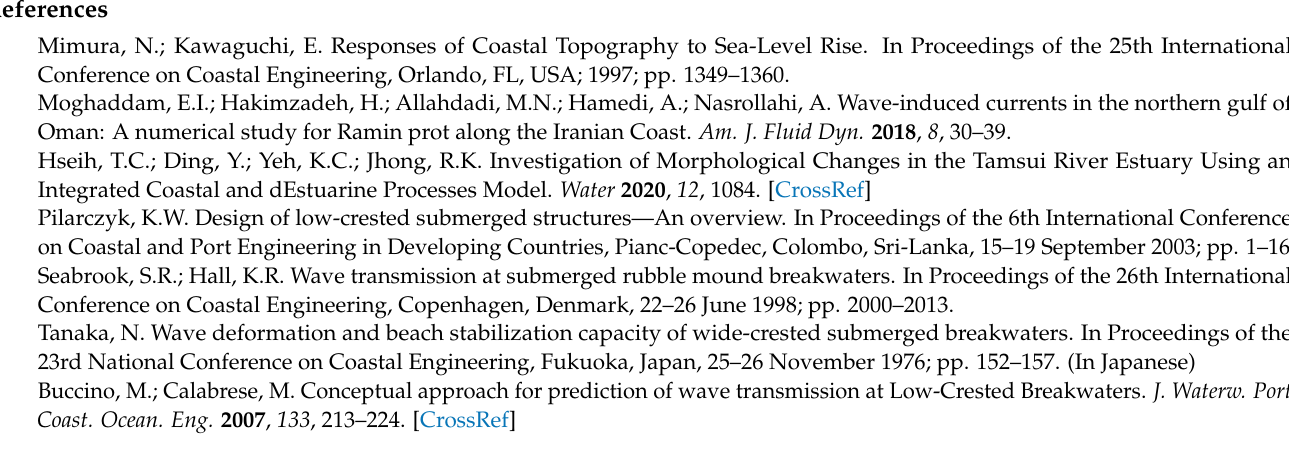
Commented [M11]: We move the explanation for subfigures to here, plaese confirm.